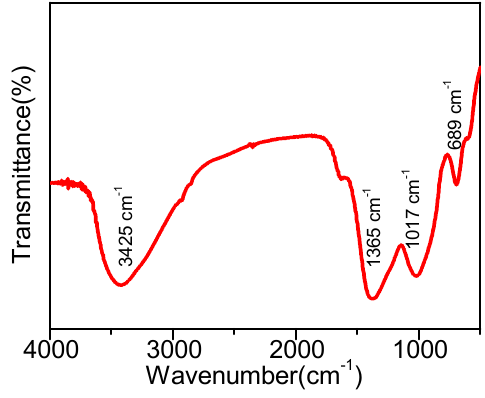
Figure 2. The FTIR spectrum of Co 3 (PO 4 ) 2 nanospheres.